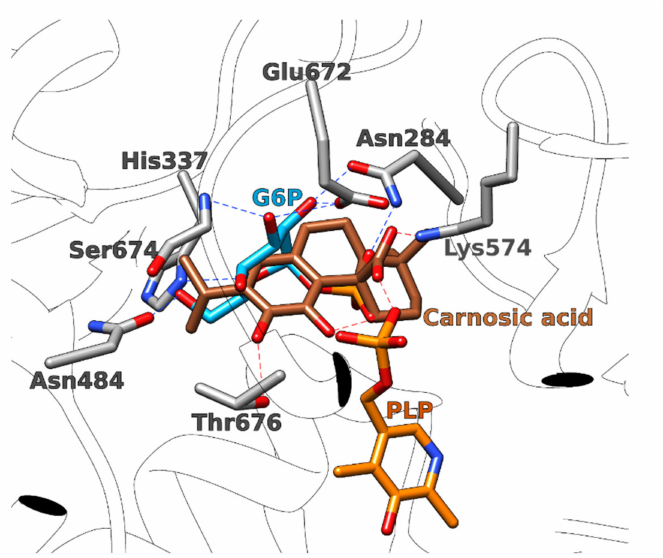
Figure 7. Glucose-6-phosphate (G6P, light blue sticks) overlapped with carnosic acid (brown sticks) in the catalytic binding site of glycogen phosphatase. Important amino acid residues are shown in grey sticks. Hydrogen bonds formed by carnosic acid are presented with red dotted lines, while the hydrogen bonds formed by glucose-6-phosphate are shown with blue dotted lines. The cofactor pyridoxal phosphate (PLP) is presented in orange